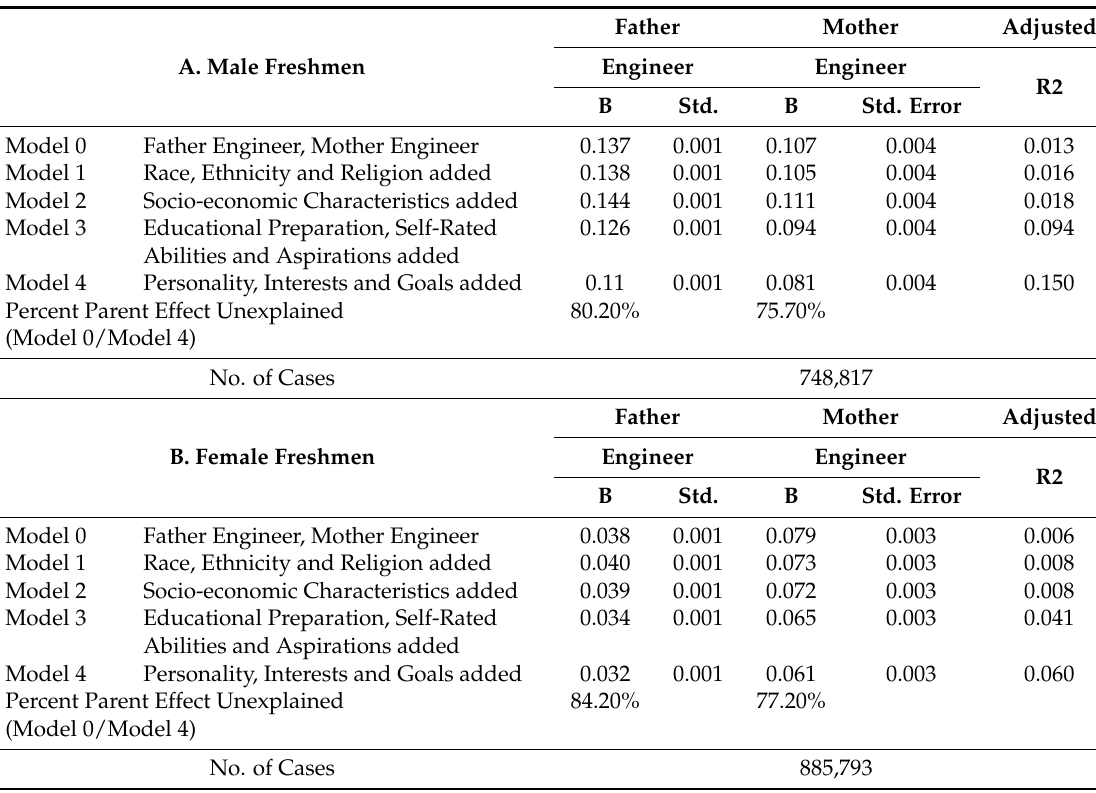
Table 4. Summary of OLS Regression